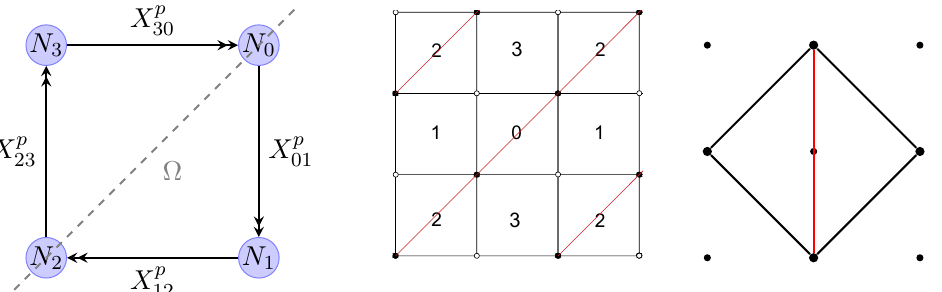
, whose quiver is drawn on the left and the dimer 2